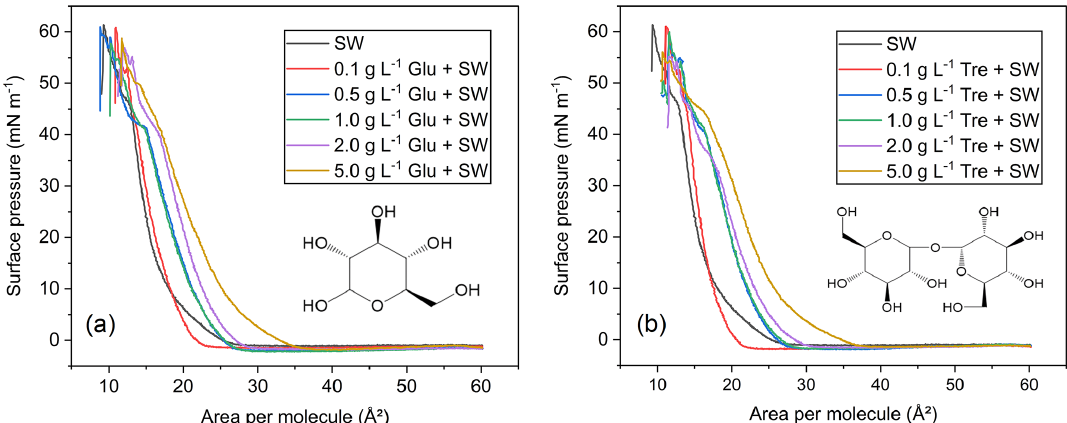
Figure 4. π - A isotherms of mixed fatty acids in the SW subphase with several concentration gradients of (a) glucose and (b) trehalose. The inset shows the molecular structures of glucose and trehalose.